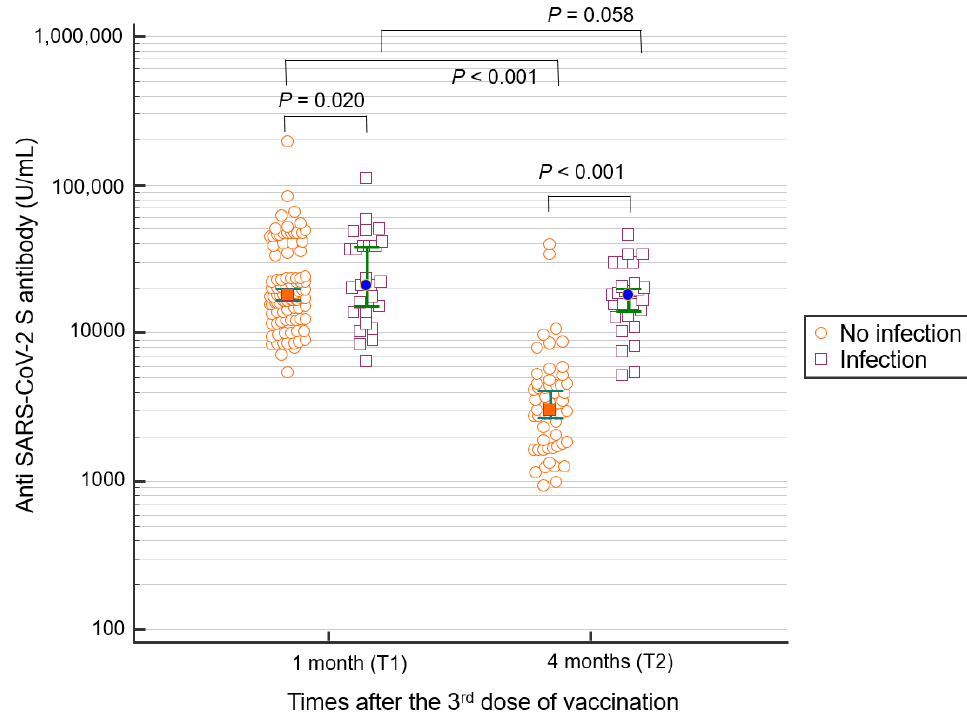
Figure 1. Anti-S antibody titer 1 (T1) and 4 months (T2) after the third vaccine dose. Participants with SARS-CoV-2 infection showed higher anti-S antibody levels than those without infection. In addition, in non-infected participants, the antibody level at 4 months after the third dose of vaccination was significantly lower than at 1 month.